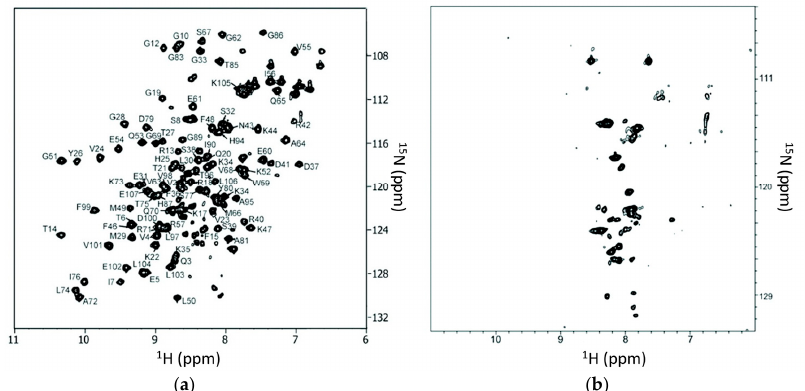
Figure 3. Application of in-cell NMR in compound screening. Peptides that can disrupt FKBP12 and FRB interactions were screened using this approach. ( a ) 1 H- 15 N-HSQC spectrum of FKBP12-FRB complex in which FKBP12 is 15 N-labeled. ( b ) Peptide affects the spectrum of FKBP12-FRB complex. This figure was reprinted with permission from the reference [84]. Copyright (2009) American Chemical Society. For more experimental details, please refer to the original